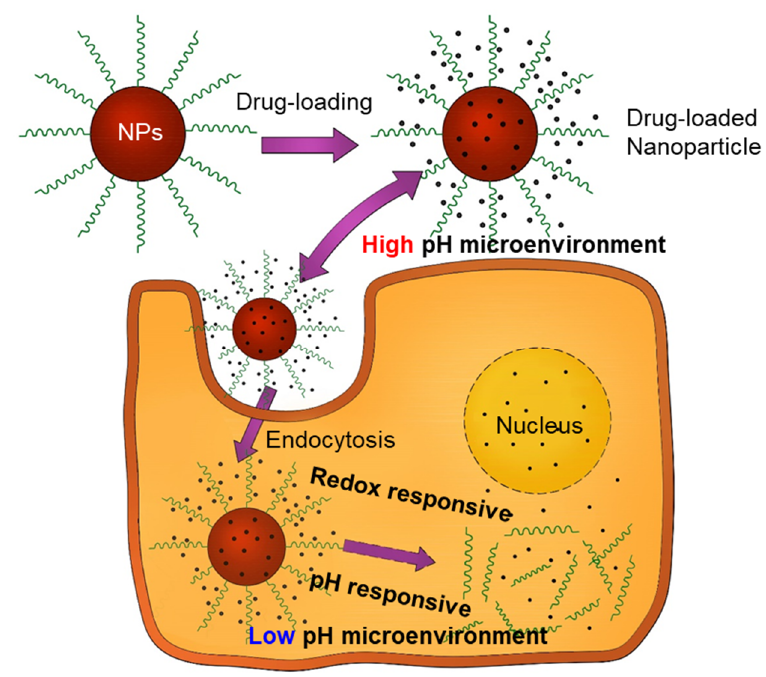
Figure 2. Schematic illustration of pH / redox potential dual-response-mediated drug release for tumor treatment. Black dots represent the drug molecules. Drugs are encapsulated inside the nanoparticles (red) and also adsorbed on the surface of nanoparticles (NPs). When endocytosis occurs, and nanoparticles are responding to a stimulus such as pH or redox potential, this may promote a drug release inside the cell.